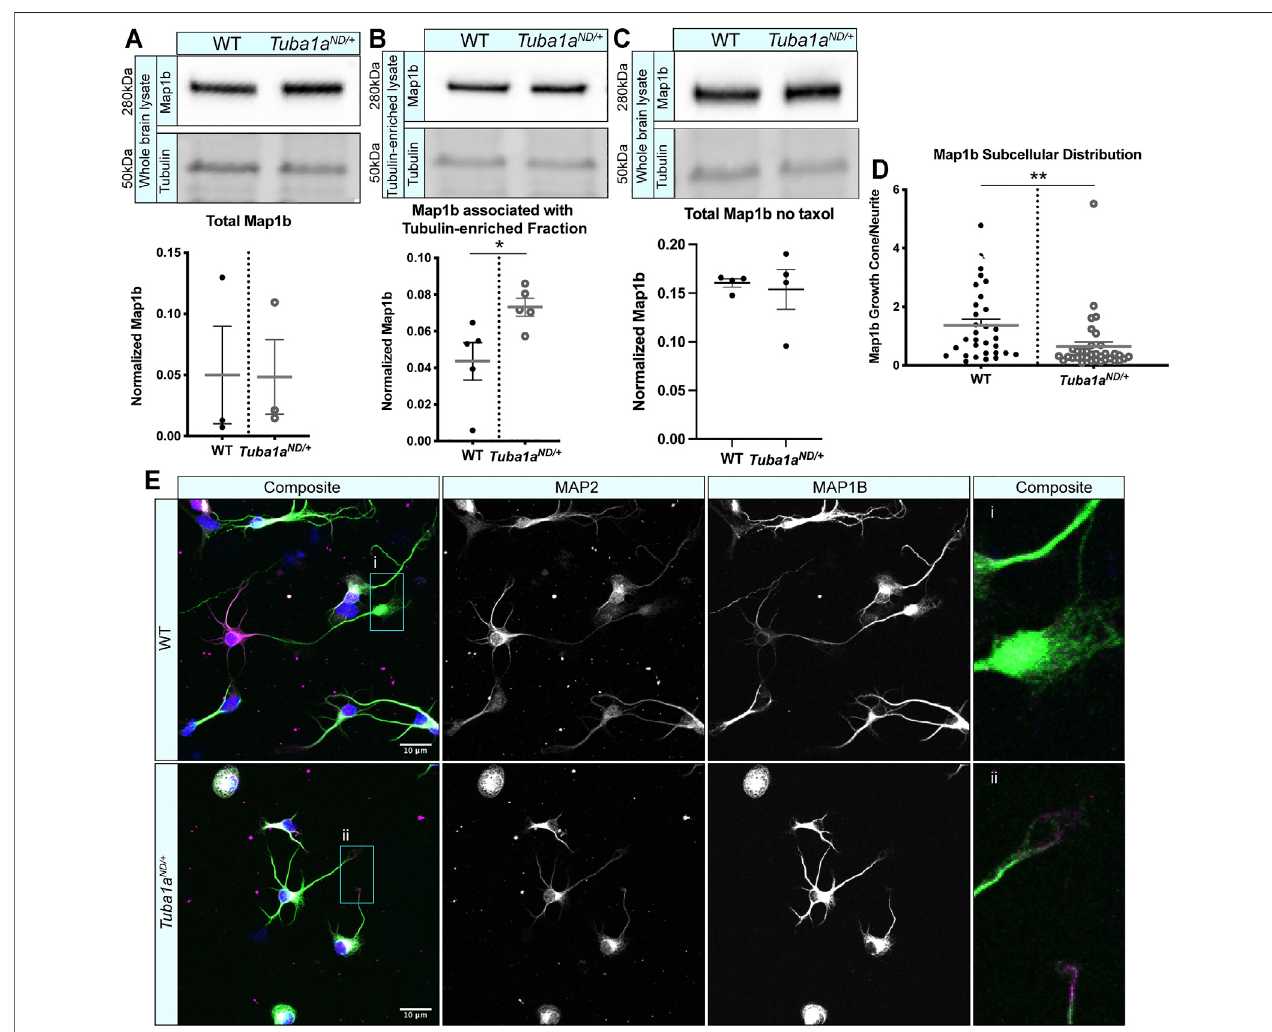
FIGURE7| Tuba1a ND neurons donot correctly localizeMap1b tothedevelopinggrowth cone. (A) Western blot showing totalMap1b protein inwhole brainlysate fromwild-type(WT)and Tuba1a ND/+ mice.ScatterplotrepresentingtotalMap1bproteininbrainlysatebywesternblot,normalizedtothetotalproteinonastain-freeblot. p (cid:1) 0.98 by t -test. (B) Western blots showing Map1b protein associated with a taxol stabilized tubulin-enriched fraction from brain (top panel). Due to the amount of protein that was loaded for Map1b western blots, antibody-stained bands for α -tubulin were oversaturated and could not be quanti fi ed, thus Map1b was normalized to the 50 kDa band (presumed to be primarily tubulin) on a UV-activated stain-free blot (bottom panel). Scatter plot quantifying Map1b associated with the taxol-stabilized tubulin-enriched brain lysate, normalized to the 50 kDa presumed tubulin band using stain-free western blotting. p (cid:1) 0.03 by t -test (C) . Western blot showing Map1b from WT and Tuba1a ND/+ pellet fraction of brain lysates without the addition of taxol. Scatter plot quantifying Map1b associated with tubulin enriched from brain lysates shows no signi fi cant difference between the amount of Map1b associated with tubulin when no taxol was added, p (cid:1) 0.76 by t -test. Map1b is normalized to the 50 kDa tubulin band using stain-free western blotting. (D) Scatter plot showing the subcellular distribution of Map1b protein in WT and Tuba1a ND/+ cortical neurons at DIV 3. Data are represented as Map1b fl uorescent signal in growth cone region divided by a region proximal to the cell body of the same area. Fluorescent images were acquired using identical microscope imaging settings between samples and were not post-processed to adjust fl uorescence prior to quanti fi cation. p (cid:1) 0.009. (E) Representative images showing altered subcellular distribution ofMap1b in Tuba1a ND/+ (bottom) cortical neurons compared to WT (top) at DIV 3. Composite and individual channel grayscale images of MAP2 and Map1b immunocytochemistry are shown, i and ii indicate enlarged regions shown in insets. Scale bars are 10 m. Differences between groups were evaluated by t test. * p < 0.05; ** p < 0.01.